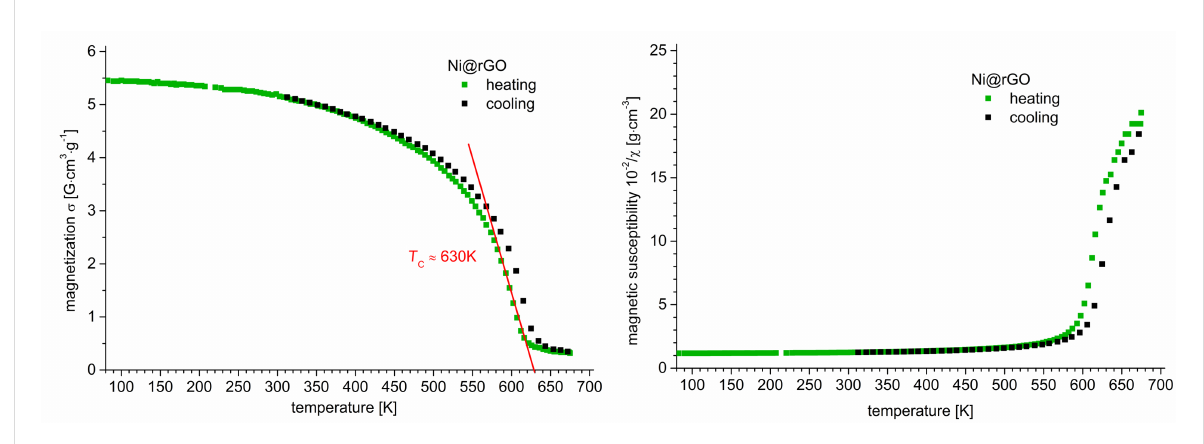
Figure 7: Left: magnetization as a function of temperature for the Ni@rGO composite in argon atmosphere. Right: magnetic susceptibility as a func- tion of temperature for nickel in argon atmosphere.